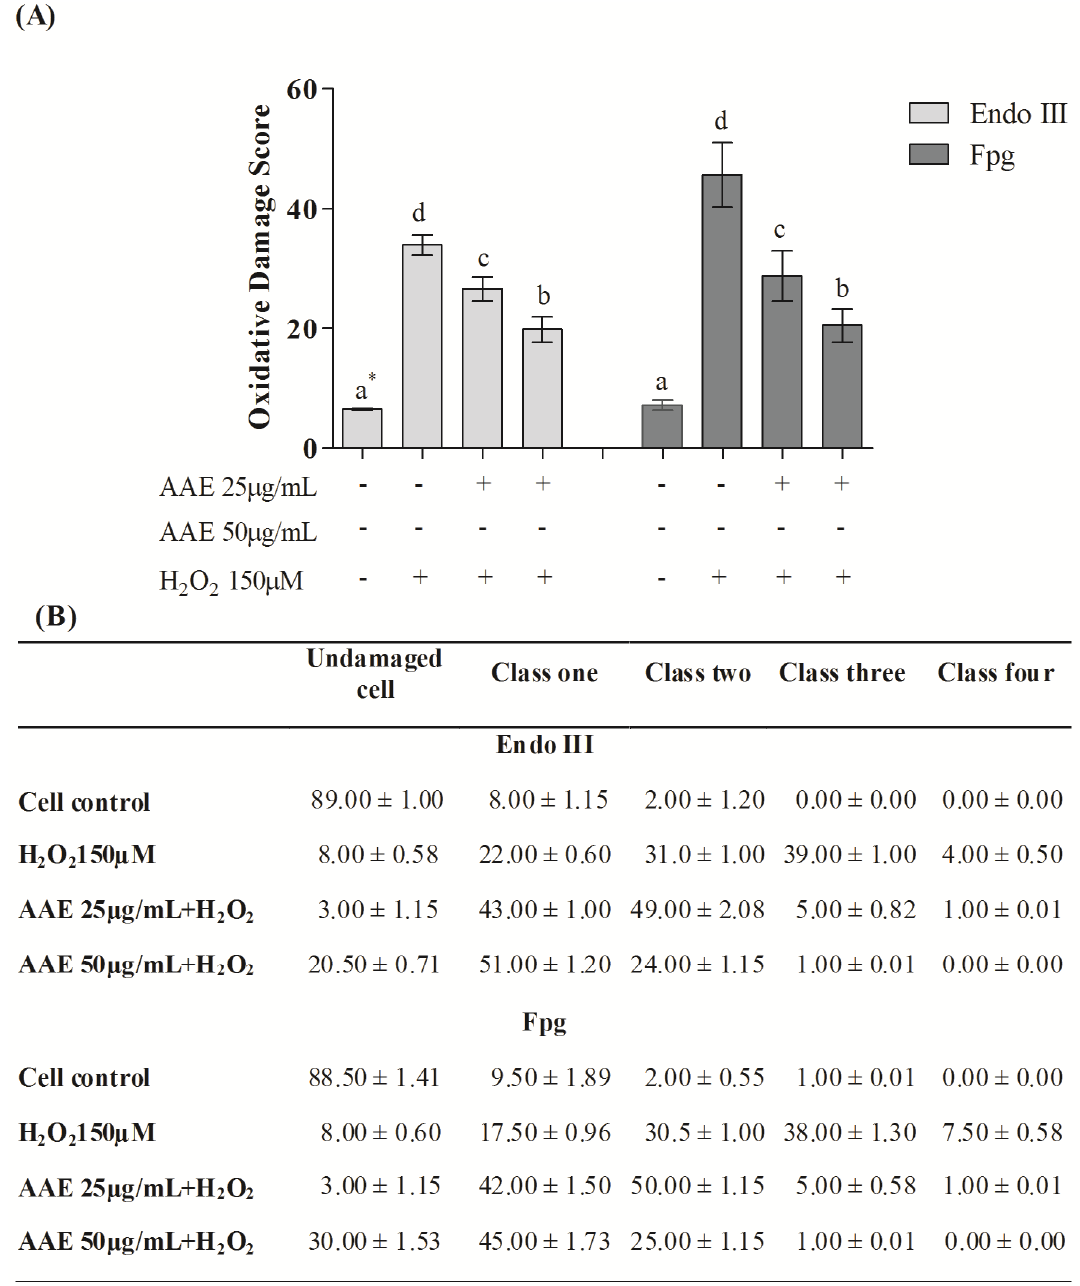
Figure 4. ( A ) Content of DNA damage oxidative by the Comet assay modified. * Different letters indicate significant differences by analysis of variance (ANOVA) and Tukey’s post-hoc test ( p ≤ 0.05). ( B ) Frequency (%) of different classes of DNA damage (Comet assay). Cells were evaluated visually and were given scores of 0 (no injury) to 4 (maximally damaged) according to the size and shape of the tail. Data are mean ± SD